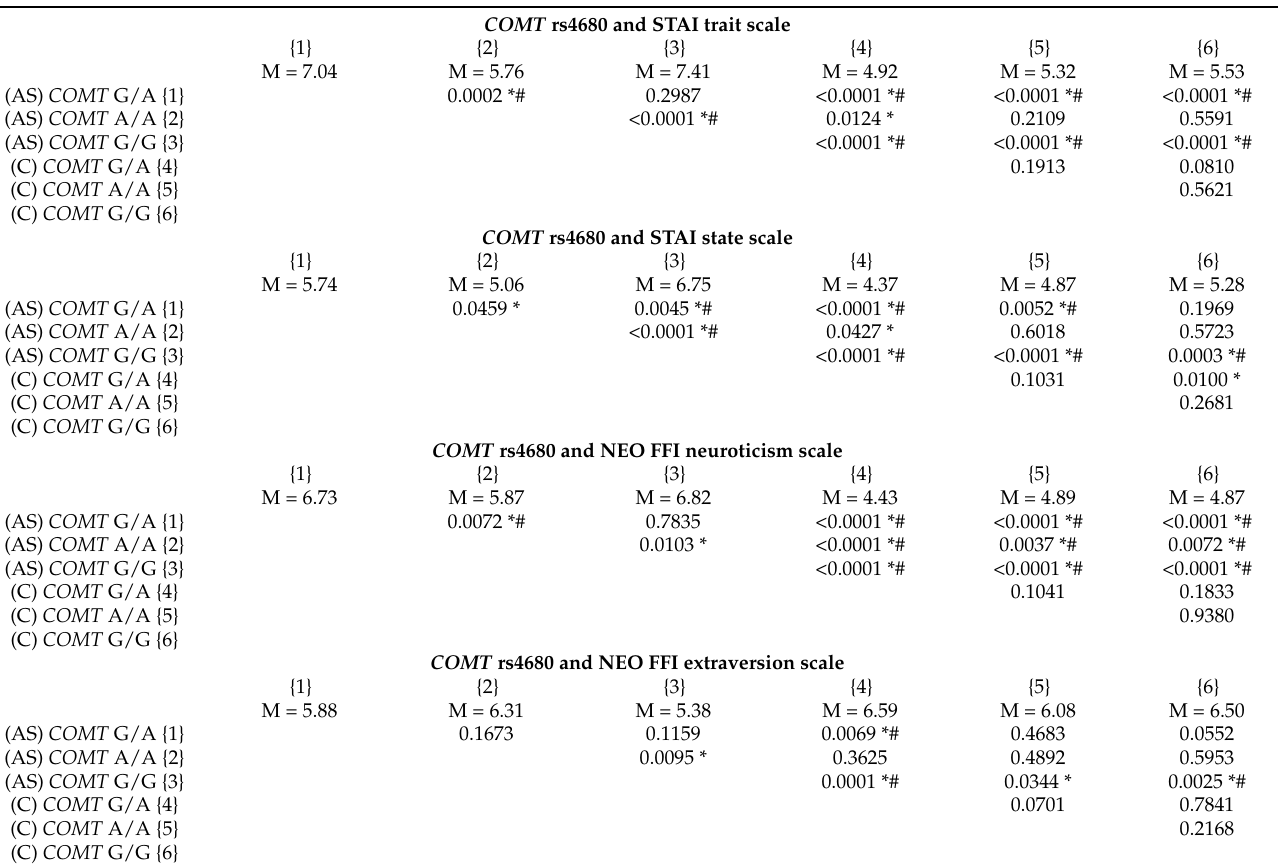
Table 7. Post hoc LSD (least significant difference) analysis of interactions between patients addicted to stimulants (AS)/-Control (C) and COMT rs4680, the STAI trait scale, STAI state scale, NEO FFI neuroticism scale and NEO FFI extraversion